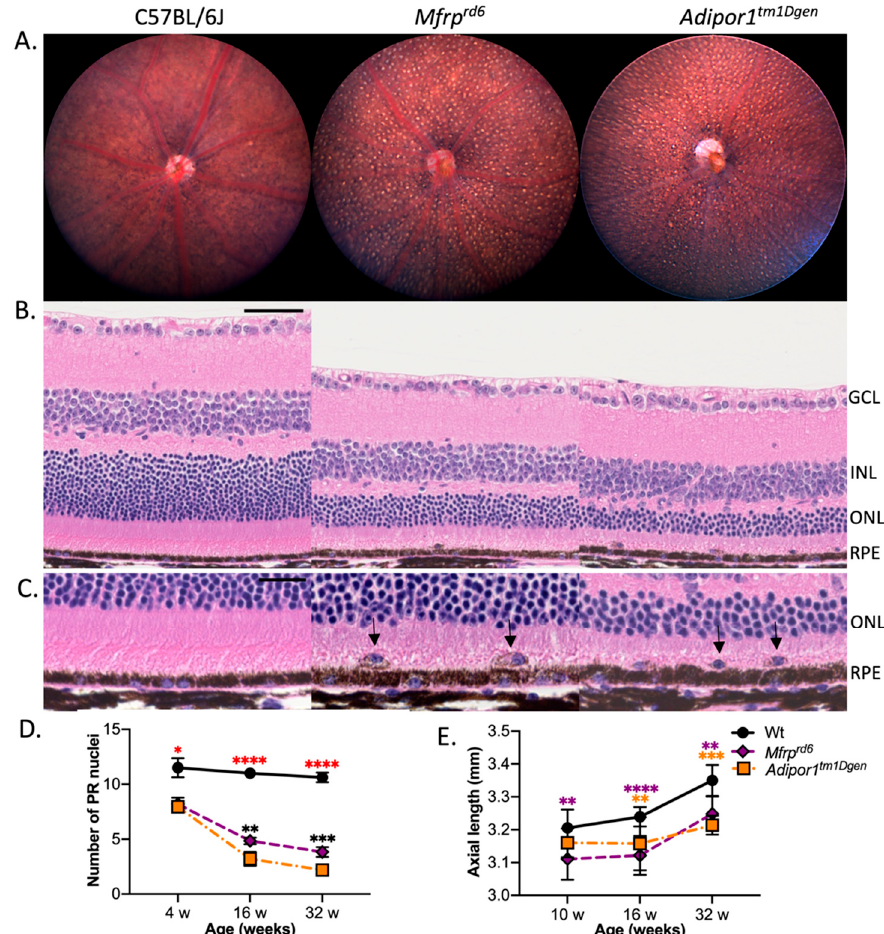
Figure 1. Mfrp rd6 and Adipor1 tm1Dgen mutant mice have similar ocular phenotypes. ( A ) Fundus photographs show evenly distributed discrete white spots throughout the retina of 4-month-old homozygous Mfrp rd6 and Adipor1 tm1Dgen mice, respectively, as compared to age-matched C57BL/6J controls. n = 9–12 per strain; both sexes included. ( B ) Retinal sections stained with hematoxylin and eosin (H&E) and visualized by light microscopy reveal significant photoreceptor degeneration by 4-months of age in both mutants compared to age-matched C57BL/6J controls. Scale bar: 50 microns ( C ). Aberrant nucleated cells containing melanin pigment, similar to MOMA2+ pigmented cells described by Hawes et al. [16], are observed in the subretinal space (black arrows) of mutant retinas only. n = 10 for each strain. Scale bar: 20 microns. Longitudinal quantification of ( D ) photoreceptor degeneration (#PR nuclei/300 µm length) and ( E ) axial length changes in single homozygotes from ( Adipor tm1Dgen x Mfrp rd6 ) F2 progeny: orange, homozygous for Adipor1 tm1Dgen and wt for Mfrp rd6 ; purple, wt for Adipor1 tm1Dgen and homozygous for Mfrp rd6 ; and black, wt for both Adipor1 tm1Dgen and Mfrp rd6 . Asterisks (*) represent the level of significance (ANOVA) between mutant and control mice; red asterisks indicate that both strains shared the same degree of significance with respect to the control, orange asterisks indicate significance between wt and Adipor1 tm1Dgen , purple asterisks indicate significance between wt and Mfrp rd6 , and black asterisks indicate significance between Adipor1 tm1Dgen and Mfrp rd6 . * p < 0.05, ** p > 0.01, *** p > 0.001, **** p > 0.0001. For PR degeneration, n = 4–6; for axial length, n = 8–15 mice. Both sexes combined.